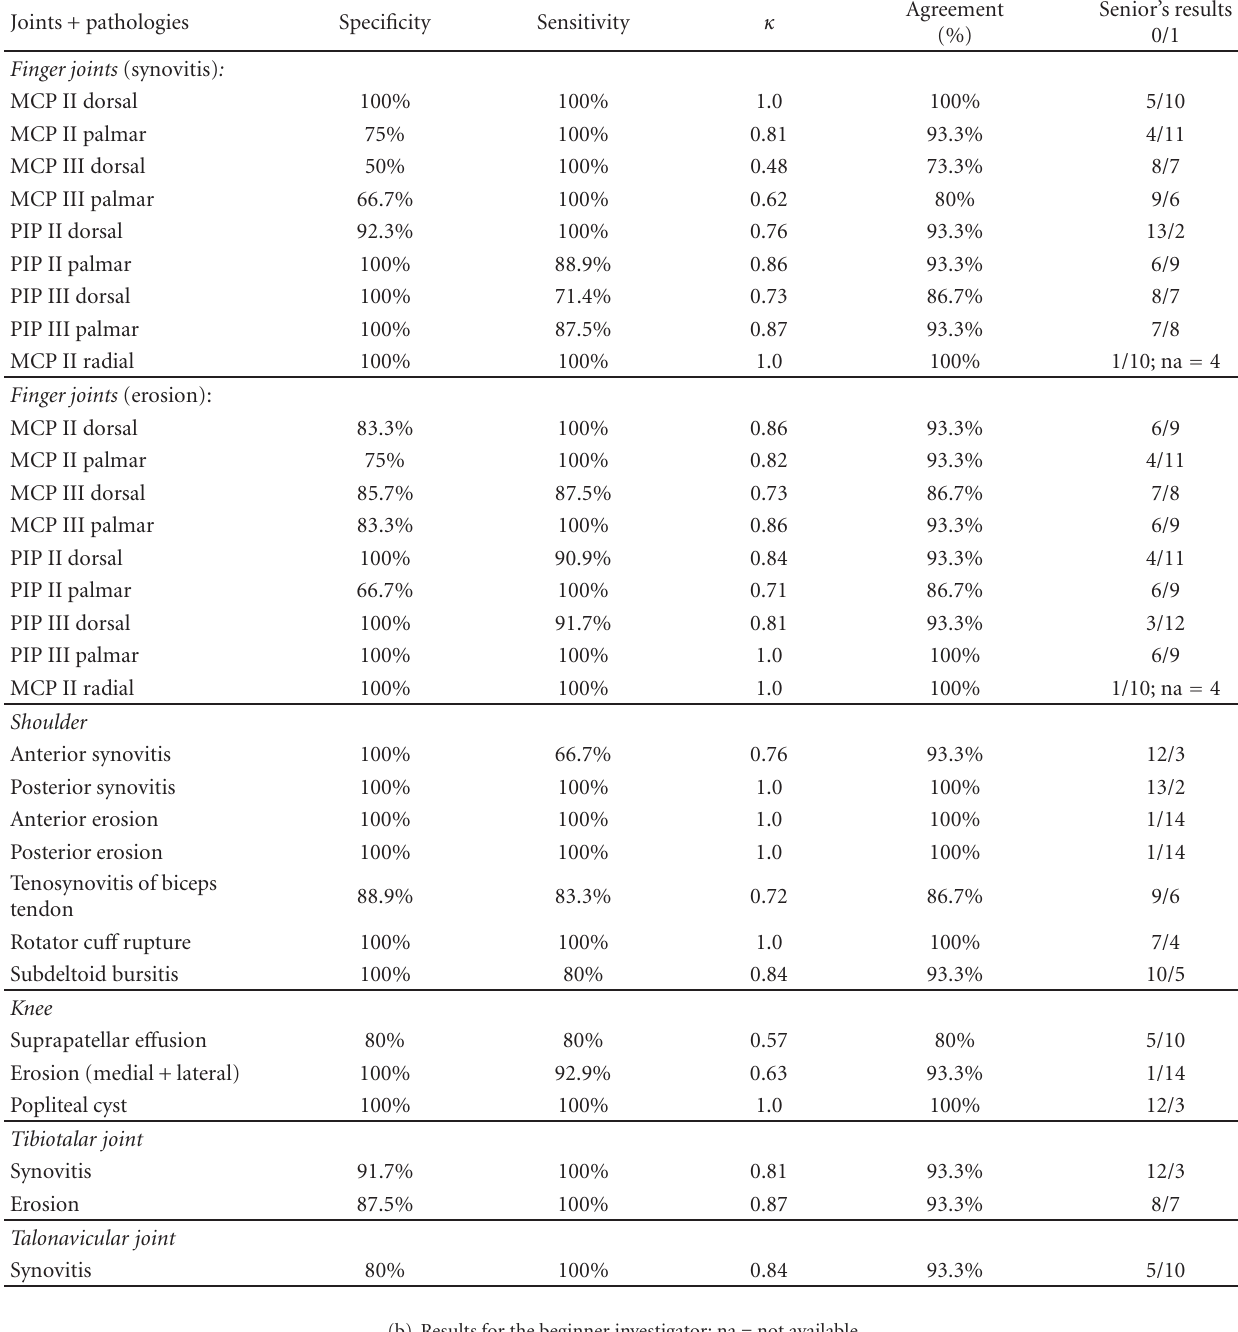
Table 2: Specificities, sensitivities, κ coe ffi cients, percentage agreements, and senior’s results for all examined joints (fingers, shoulder, knee, tibiotalar, and talonavicular joints) and each joint region reached by the junior (a) and beginner investigator (b). (a) Results for the junior investigator; na = not